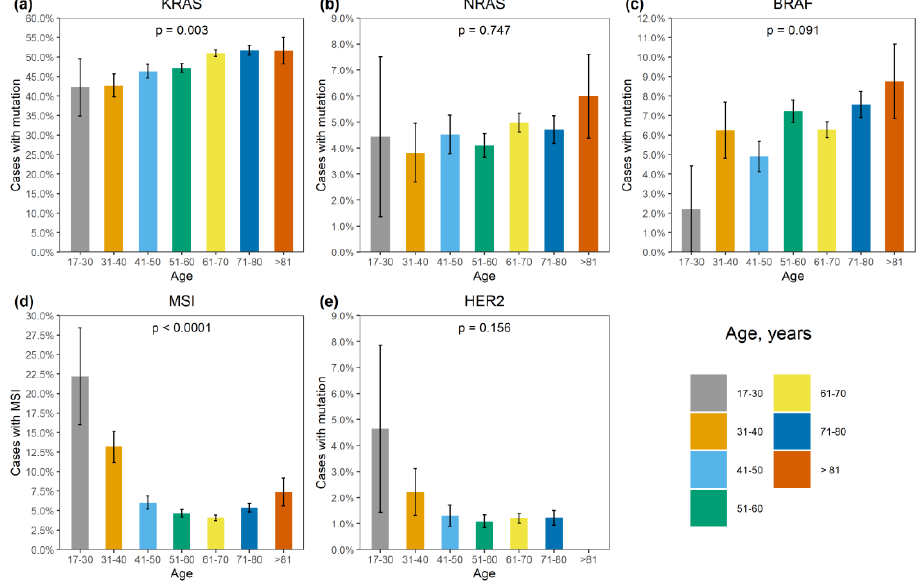
Figure 2. Association of genetic alterations with age. ( a ) KRAS mutation, ( b ) NRAS mutation, ( c ) BRAF mutation, ( d ) MSI, ( e ) HER2 amplification.